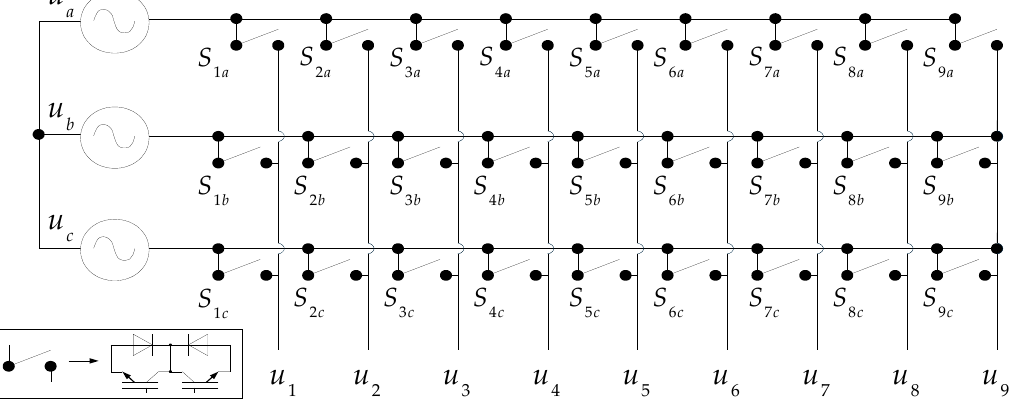
Figure 1. Scheme of the three-to-nine-phase multiphase matrix converter (MC) topology. Inputs are named u a , u b , u c , and outputs are named u 1 – u 9 .